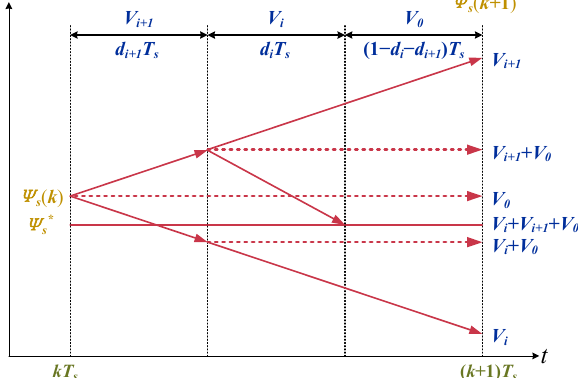
Figure 8. Schematic view of the different voltage vectors on the stator flux linkage vectors.